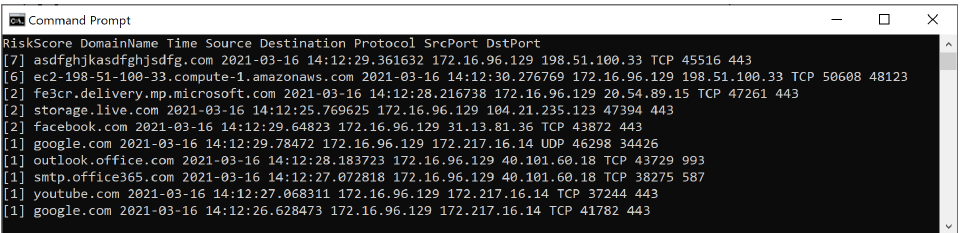
Figure 25. Console window - Top 10 Highest Risk Score